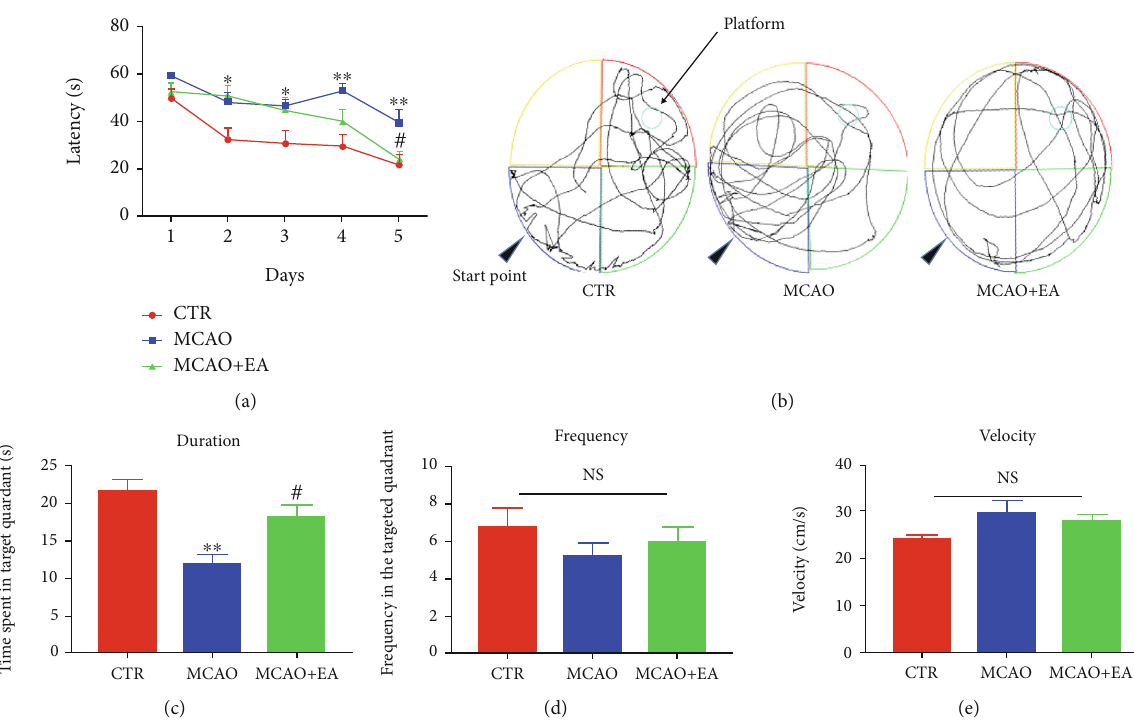
Figure 3: E ff ects of the MCAO and EA in the water maze test. Escape latency to the invisible platform in the training phase (a), representative swimming track (b), time spent in targeted quadrant (c), frequency in the targeted quadrant (d), and velocity in the water maze (e). Data are expressed as mean ± SEM , where ∗ p < 0 : 05 and ∗∗ p < 0 : 01 compared to the control group and # p < 0 : 05 compared to the MCAO group ( n = 10 each group). NS: no signi fi cance; CTR: control; MCAO: middle cerebral artery occlusion; EA: electroacupuncture.